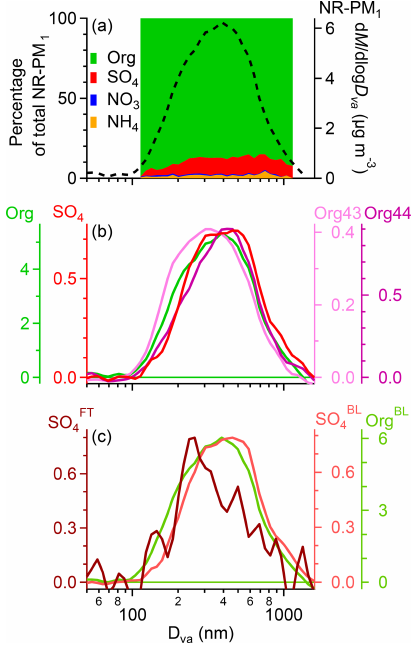
Figure 5. (a) Size-resolved aerosol composition on the left axis and average size distributions of total NR-PM 1 mass on the right. (b) Average mass-based size distributions of organics, sulfate, Org43, and Org44 during the clean periods. (c) Average mass-based size distributions of FT sulfate and BL-influenced sulfate and organ- ics. The units for the y axes in (b) and (c) are µgm − 3